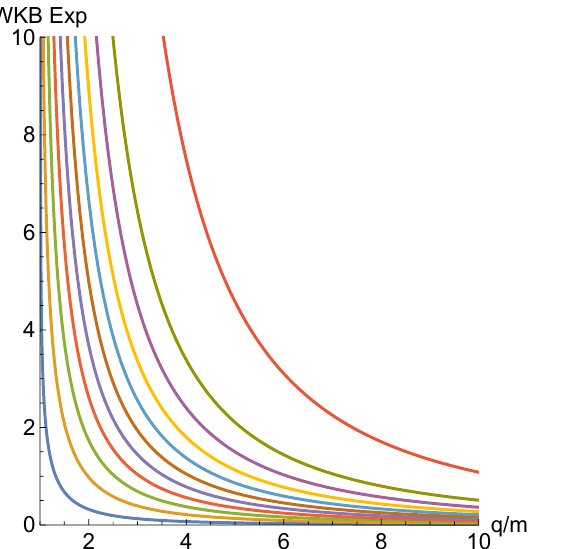
Figure 3 . The WKB exponent in eq. (2.32) for mL = 10 3 as a function of q=m . From bottom to top the curves correspond to Q = ( L=m; : : : ; Q max ). Higher curves (larger Q ) have increasingly suppressed discharge rates, but are increasingly unstable against tunneling to expanding